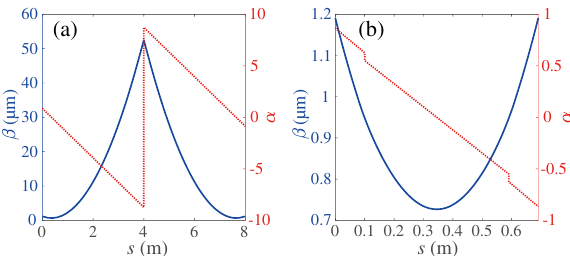
FIG. 14. Longitudinal Twiss matching of two arcs. (a) One rf or laser modulator at the cente.; (b) Two rfs or laser modulators set